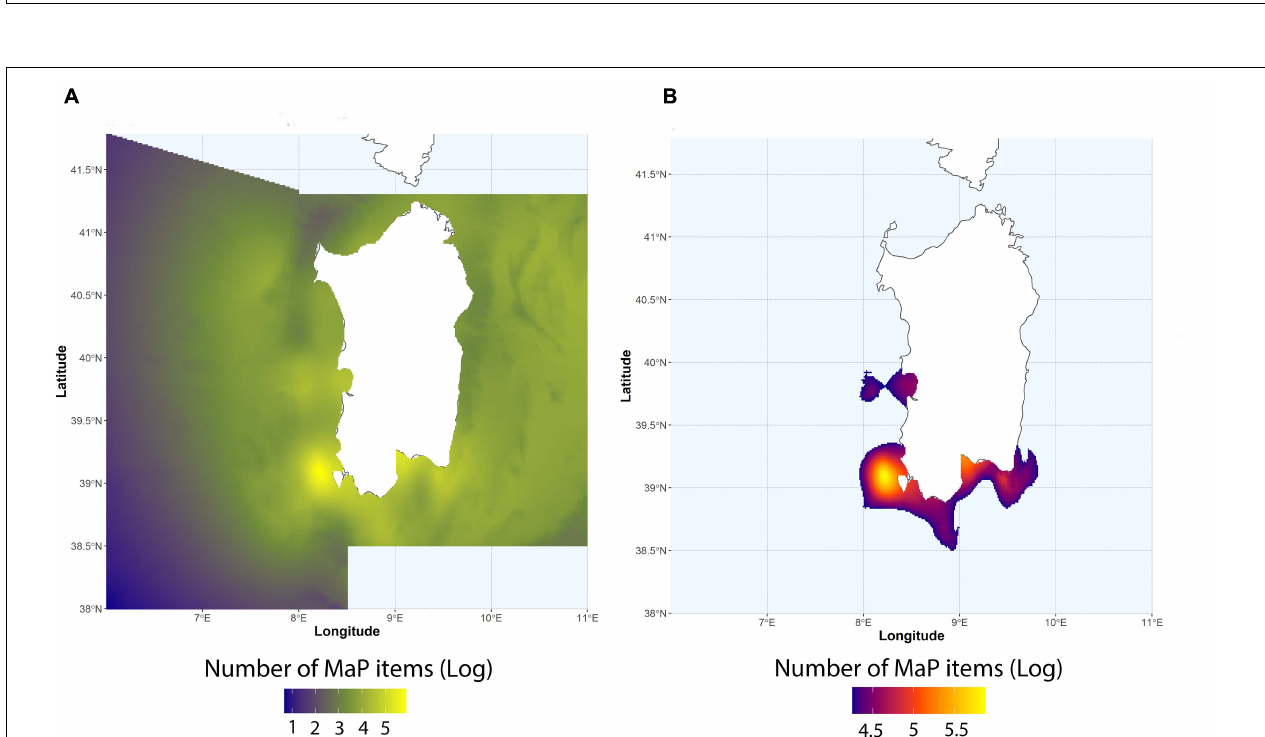
FIGURE 3 | Total fishing effort (in hours) for the years 2017 and 2018 for trawling vessels. Values are log-transformed.